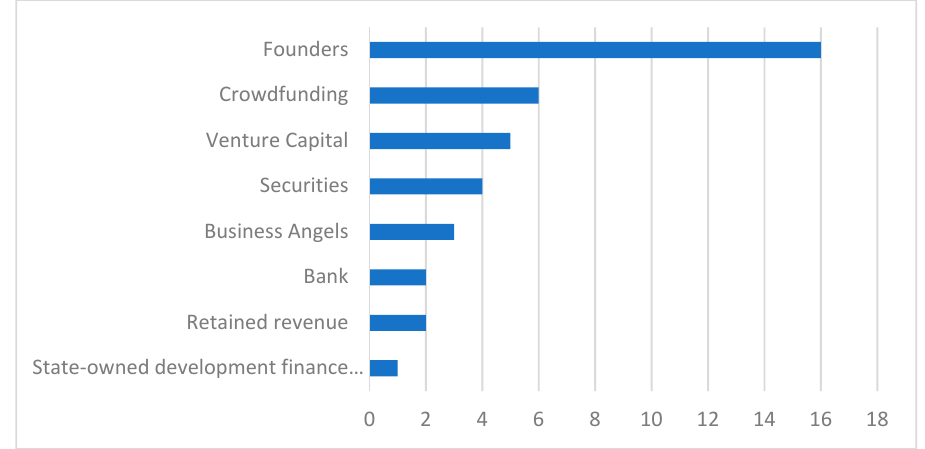
Figure 3. Sources of funding, number of FinTech (multiple responses allowed) .